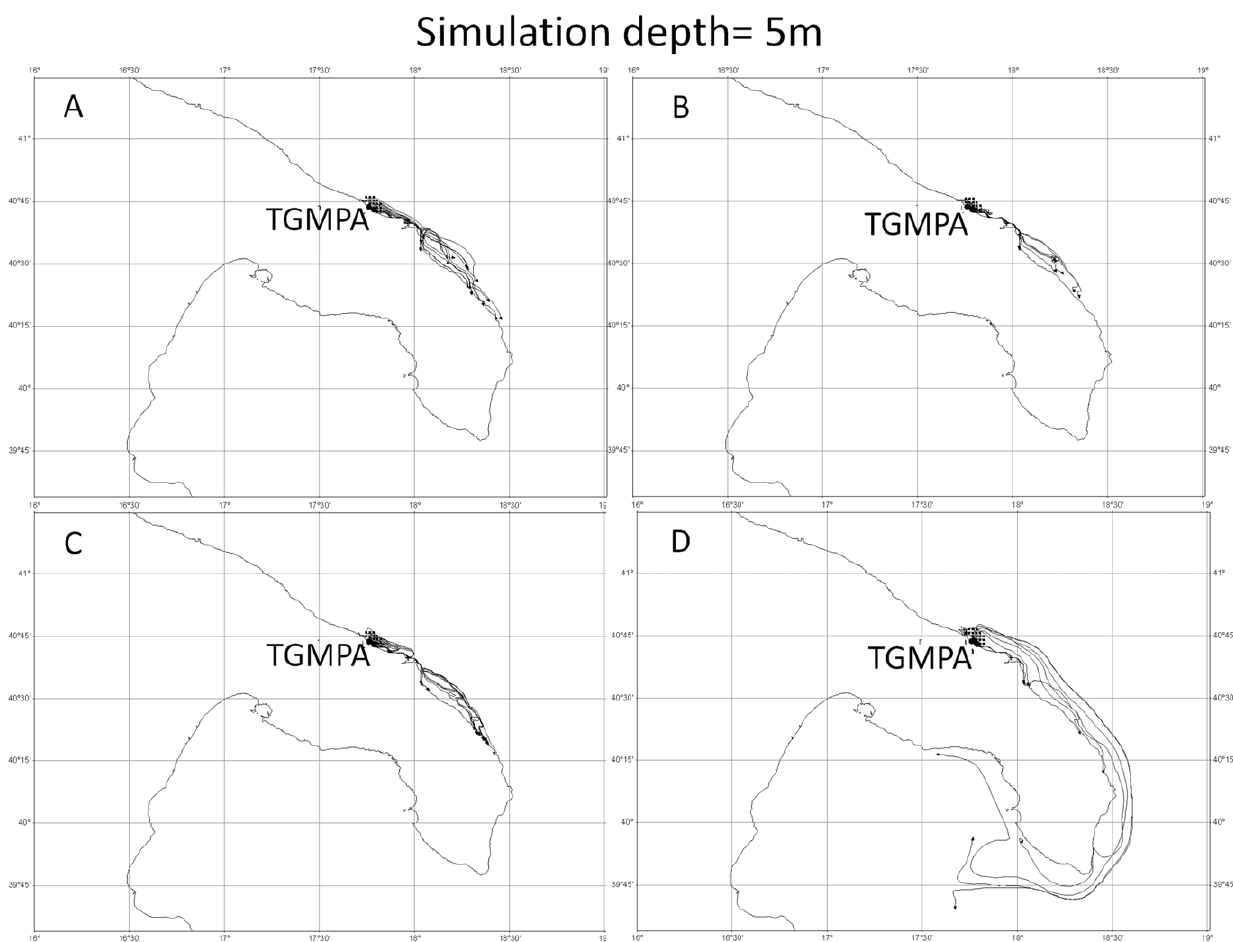
Figure 6. Four Lagrangian simulations at 5 meter depth. Simulations started respectively a) on 9 th , b) 11 th , c) 13 th , d) 15 th of May. All simulations lasted 17 days.